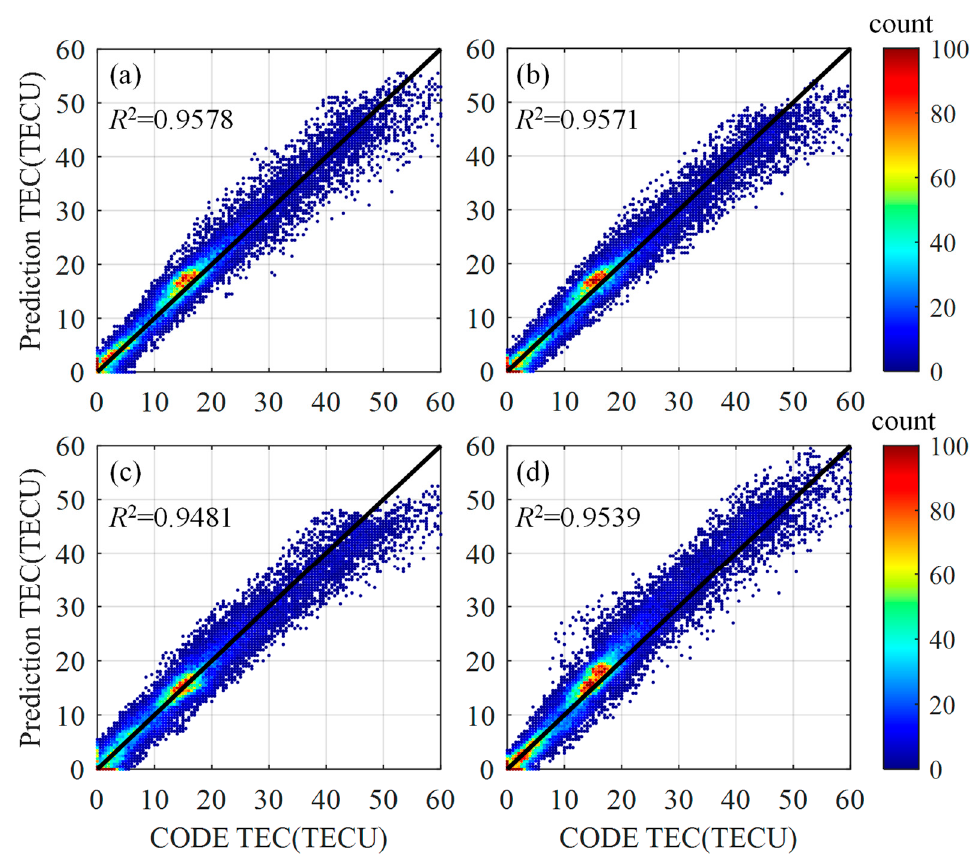
Figure 8. Correlation analysis between forecasted values and CODG values on 1 June in a year of high solar activity. ( a – c ) Scatter density plots of the correlations between the 7-day, 15-day and 30-day Prophet model forecasted values, respectively, and the CODG values. ( d ) Scattered density plot of the correlation between the COPG and CODG values.